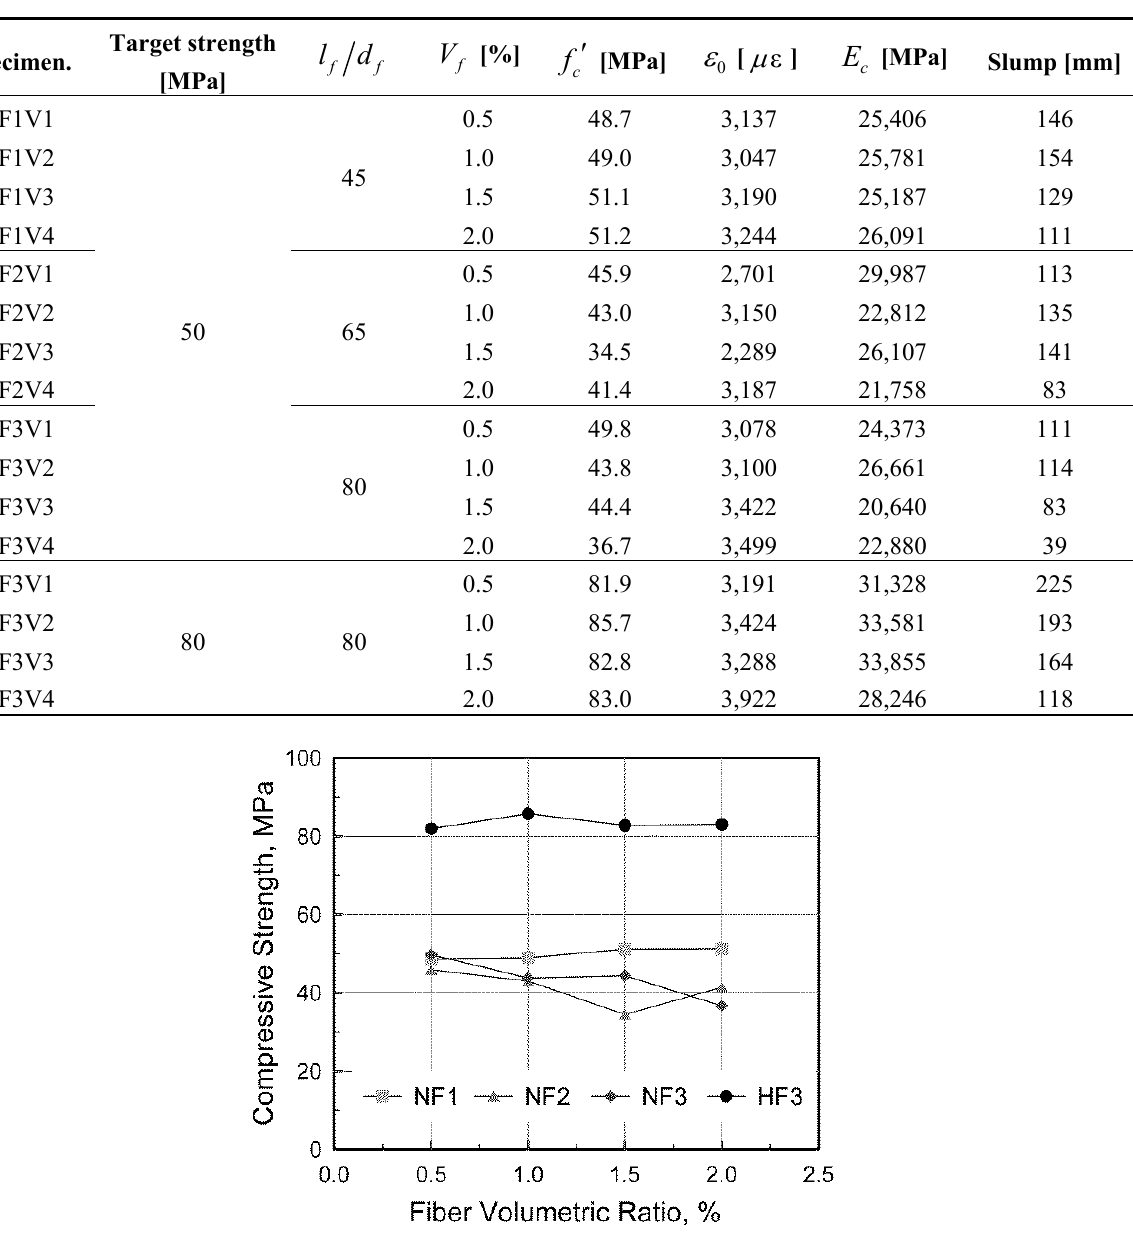
Figure 2. Measured compressive